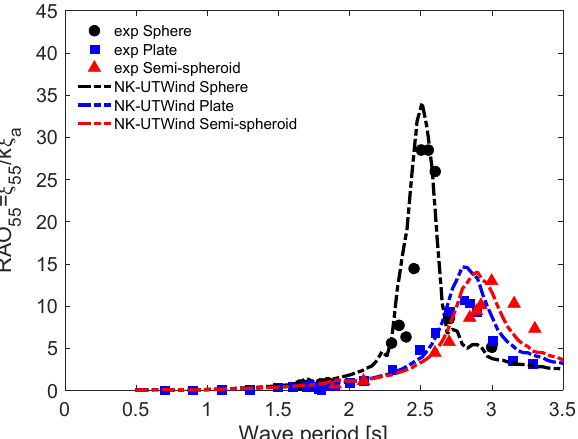
Figure 16. Response amplitude operator (RAO) pitch motion comparisons between the experiment and NK-UTWind numerical calculations for medium wave height and different heave plate configurations.